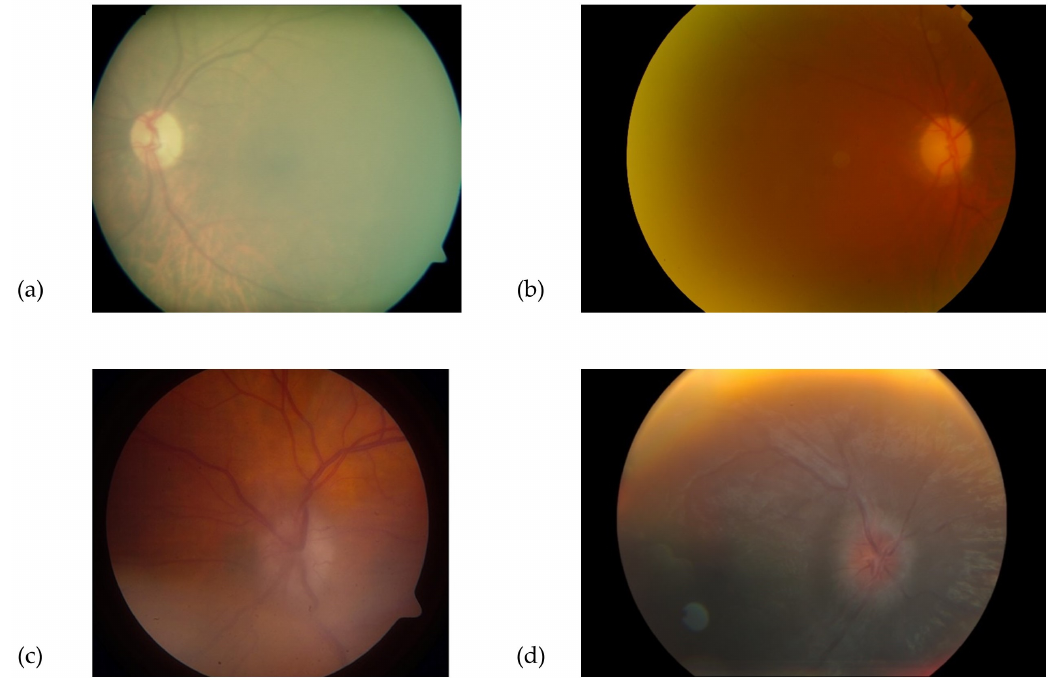
Figure 2. Examples of “borderline” quality colour fundus images. Despite the partial image blur, an evaluation of the optic disc is still possible ( a – d )